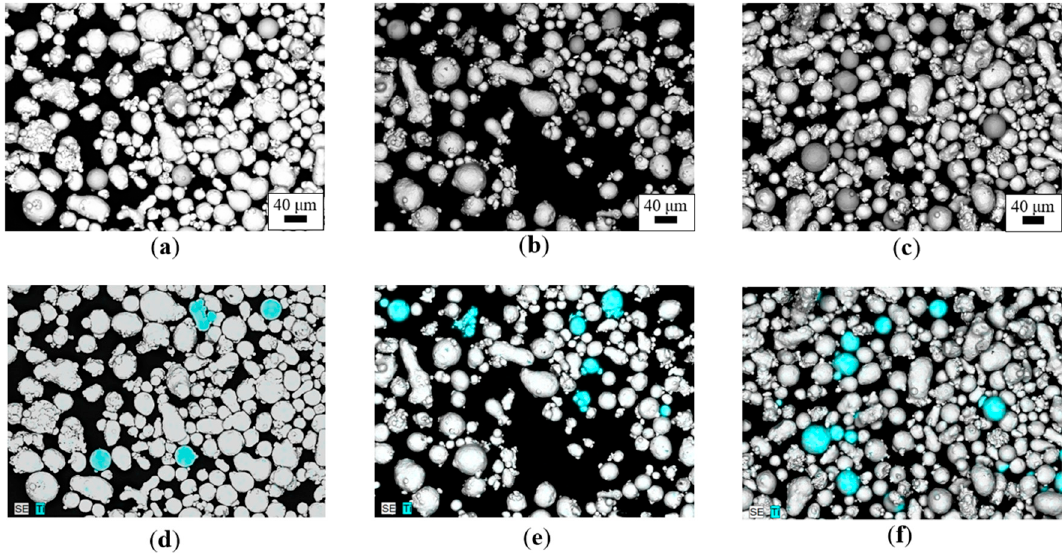
Figure 4. SEM–BSE micrographs of the MS-based cross-contamination samples: ( a ) MS + 0.5Ti64, ( b ) MS + 1Ti64, ( c ) MS + 2.5Ti64, and the respective energy-dispersive spectroscopy (EDS) elemental maps: ( d ) MS + 0.5Ti64, ( e ) MS + 1Ti64, ( f ) MS + 2.5Ti64. Blue particles correspond to Ti64.